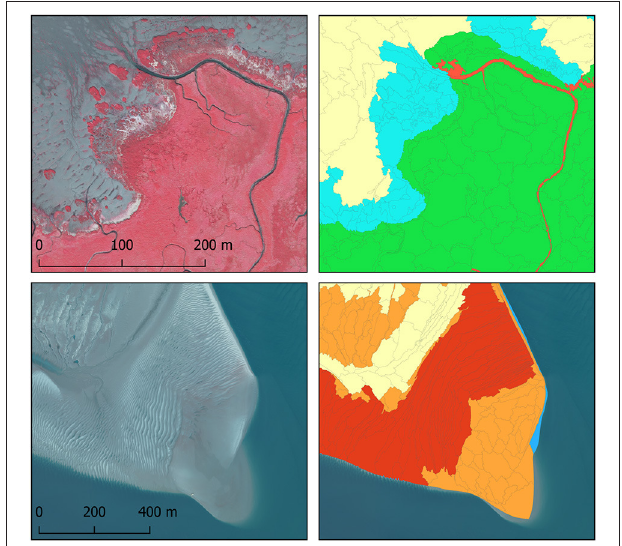
FIGURE 3 | Examples of the most common surfaces on the aerial photographs (left) and biogeomorphological maps (right) for vegetated classes (top) and intertidal flat classes (bottom) . For legend see Figure 2